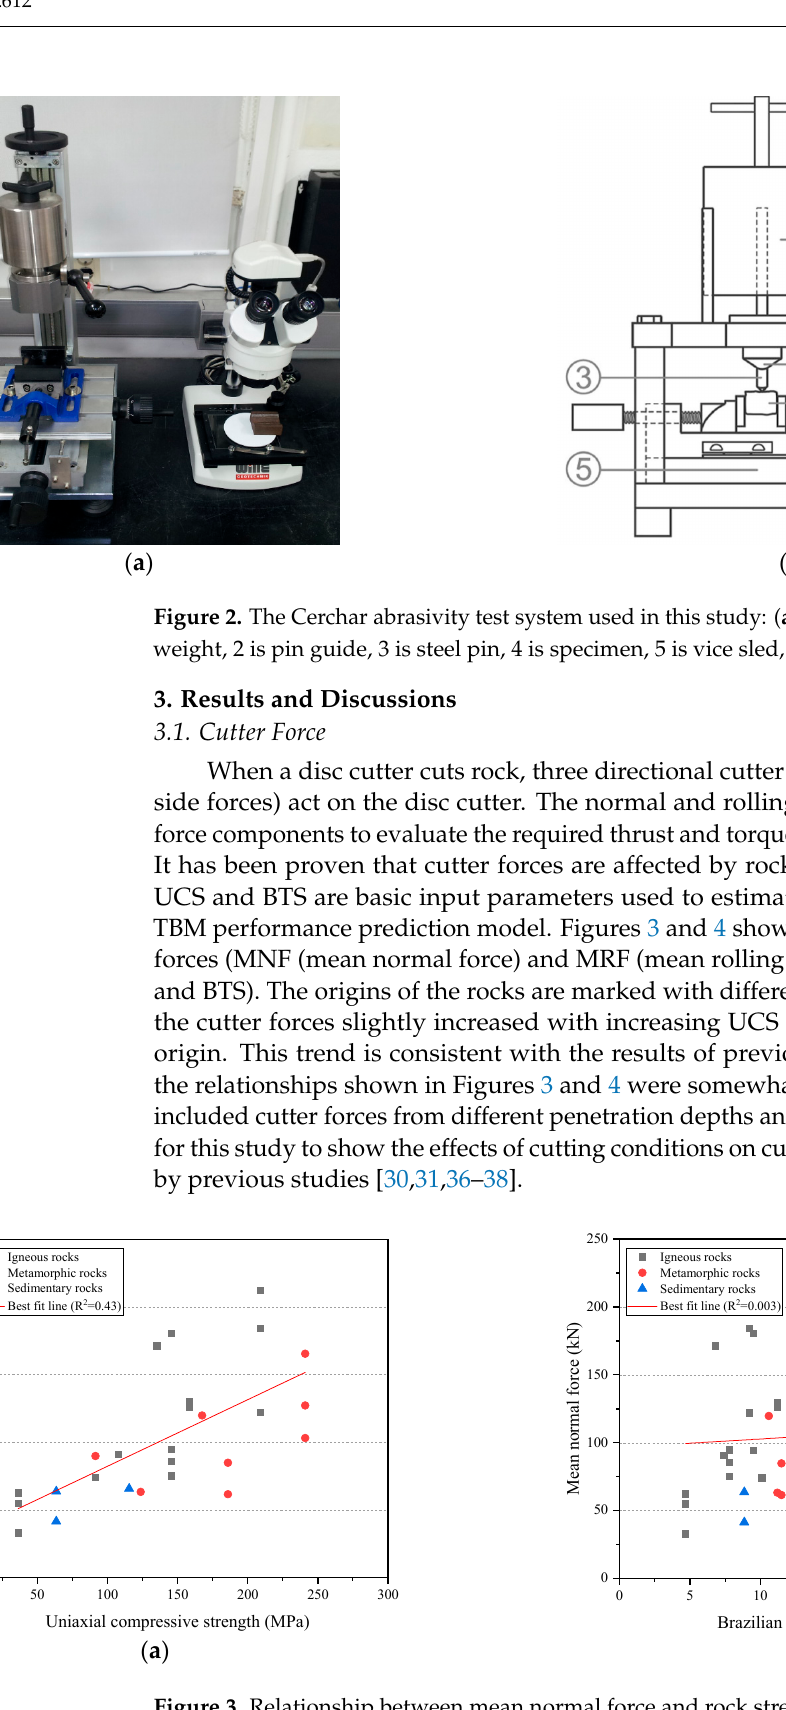
( b ) Figure 4. Relationship between mean rolling force and rock strengths: ( a ) UCS; ( b ) BTS. To diminish the effect of the penetration depth, the boreability index (BI) can be used for the quantitative analysis of the relationship between rock strengths and cutter forces. The BI is usually called the field penetration index (FPI). The BI is calculated as the ratio of the normal force to the penetration depth, while the FPI is calculated as the ratio of the thrust per each cutter to the penetration depth per revolution [37,39]. Figure 5 shows the relationship between the BI and cutter forces. The results show that significant linear re- lationships were found in the case of the normal force, as shown in Figure 5a. However, the rolling force had a poor correlation with the BI, as shown in Figure 5b. The rolling force is usually estimated based on the empirical relationship between the normal force and the rolling force. This relationship can be expressed as the concept of the cutting coefficient (CC), which is defined by the ratio of the rolling force to the nor- mal force. As shown in Figure 6a, the average CC for the Korean rock types included in this study was 8% on average, and the CC range was consistent with the findings of pre- vious studies [30,37]. However, as shown Figure 6b, there are no significant relationships between CC and rock strengths in the database. The result is not consistent with the find- ing from the previous study [37].